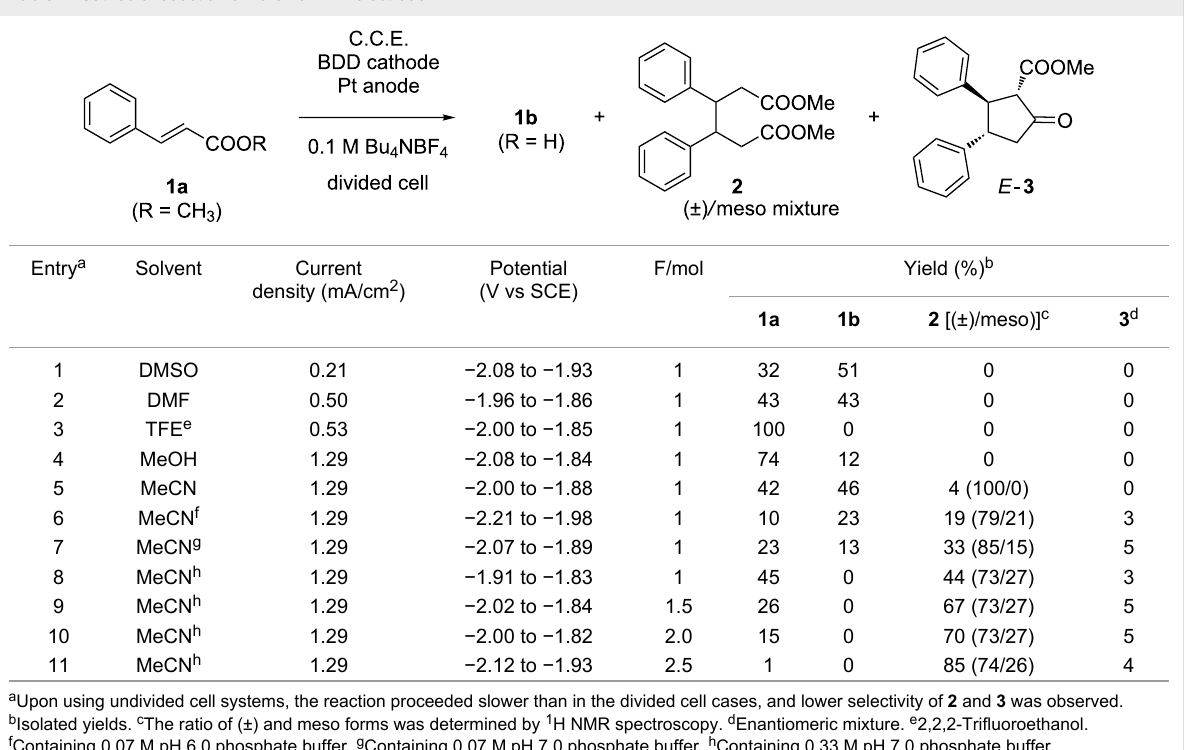
Table 1: Cathodic reduction of 1a on a BDD electrode.